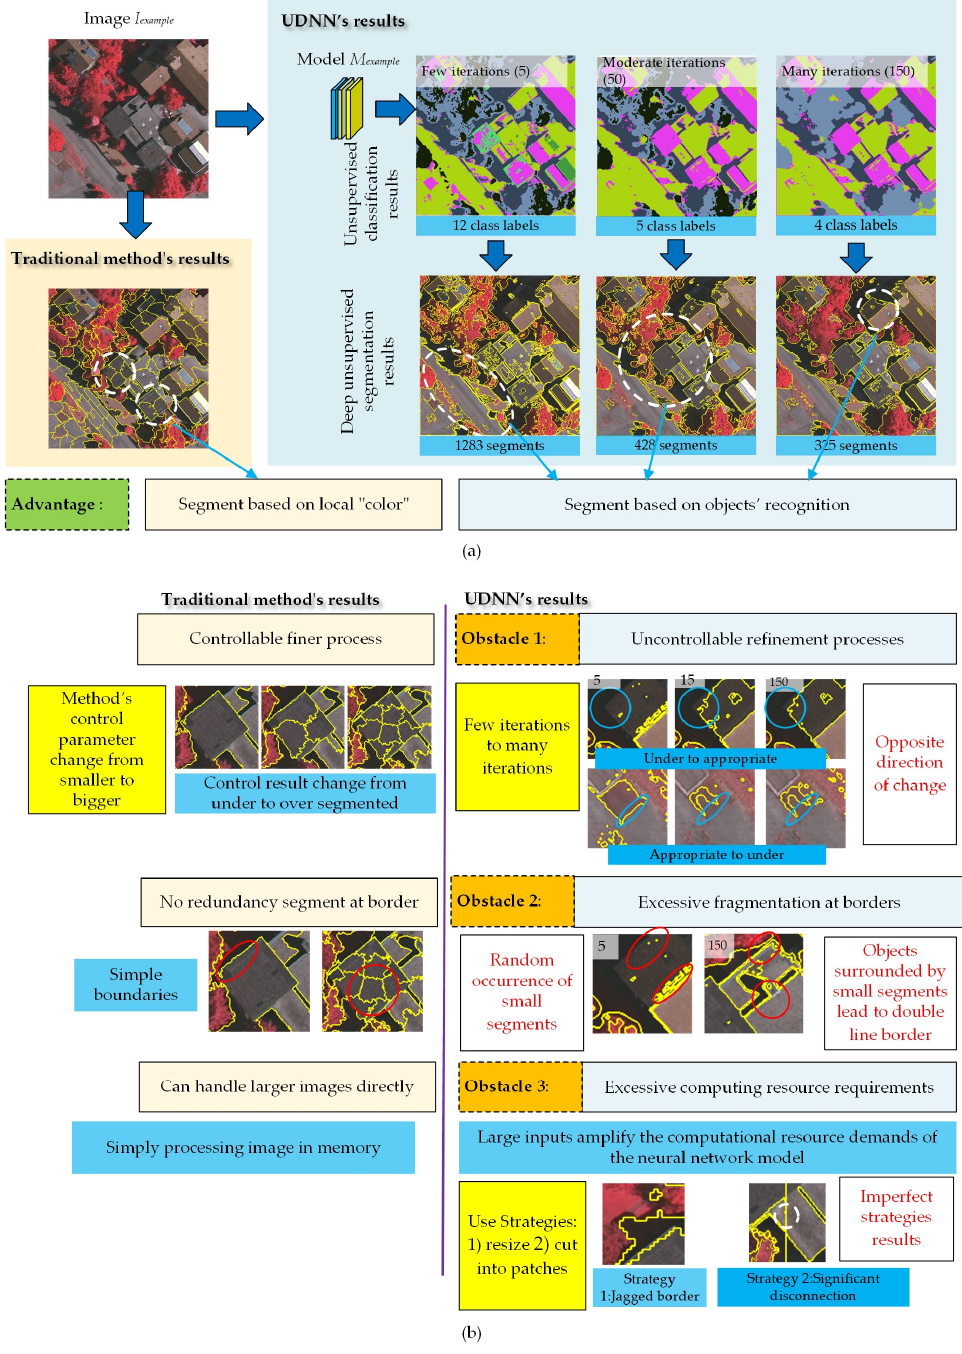
Figure 1. Obstacles hindering deep unsupervised remote sensing image segmentation: ( a ) segmentation results of a UDNN; ( b ) illustrated obstacles.